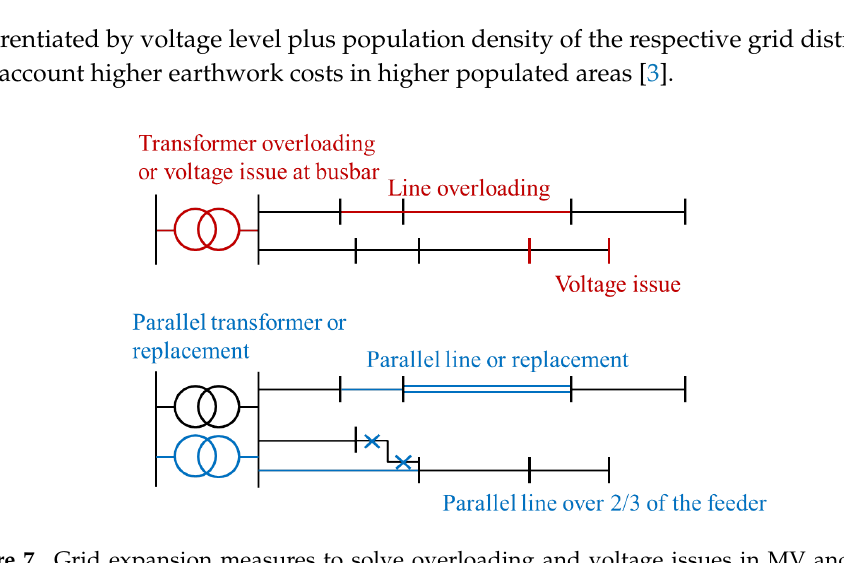
Figure 7. Grid expansion measures to solve overloading and voltage issues in MV and LV grids based on [31].